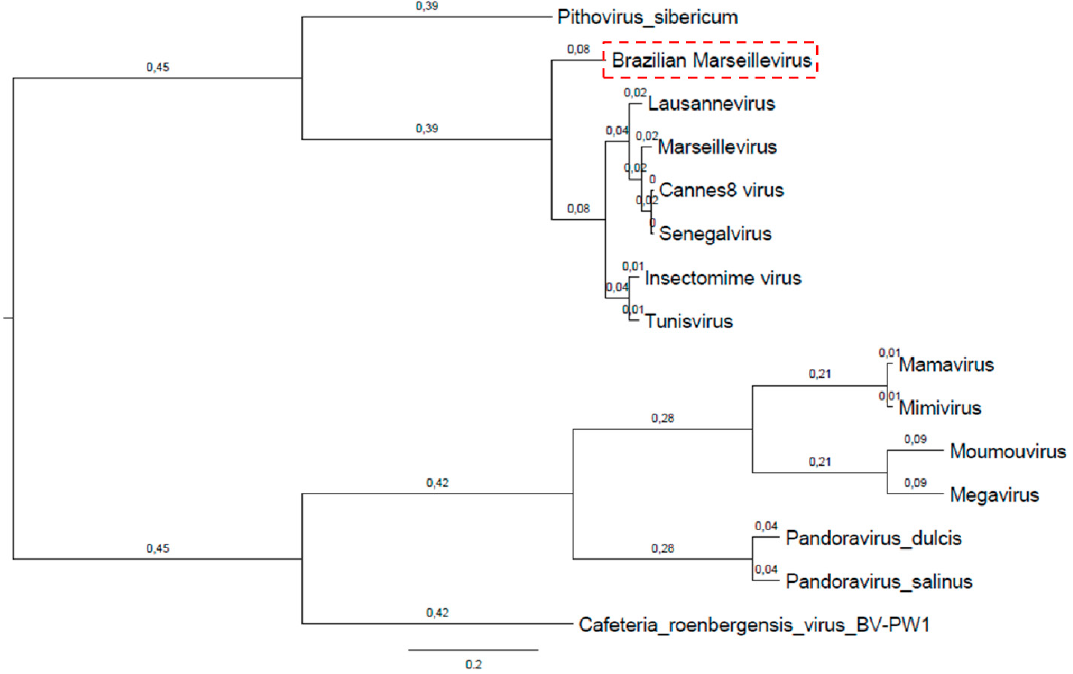
Figure 5. Hierarchical clustering tree based on phyletic patterns. Phylogeny based on the presence-absence matrix of 5443 NCVOG (clusters of orthologous genes shared by nucleocytoplasmic large DNA viruses). The Pearson correlation was used as metric distance, and the scale bar means the branch time.